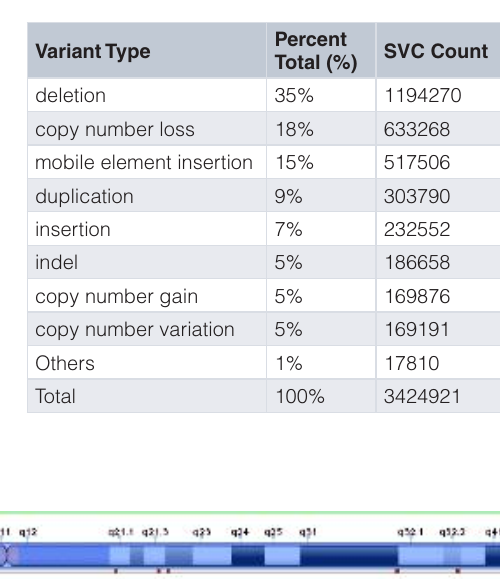
Table 1. SVC count and percentage of total by variant types from combined-set across all studies. The most common variant type was deletion followed by CNV. All CNV types combined (rows 1, 7, and 8 in Table 1) total 972,335. We also generated SVC for each variant type (ie. CNV, in/del, etc.) and by individual studies (study-set) for QA/QC and analysis between types and studies of interest. The study-set generated a total of 2.5 million SVCs versus 3.4 million SVCs from the combined-set.